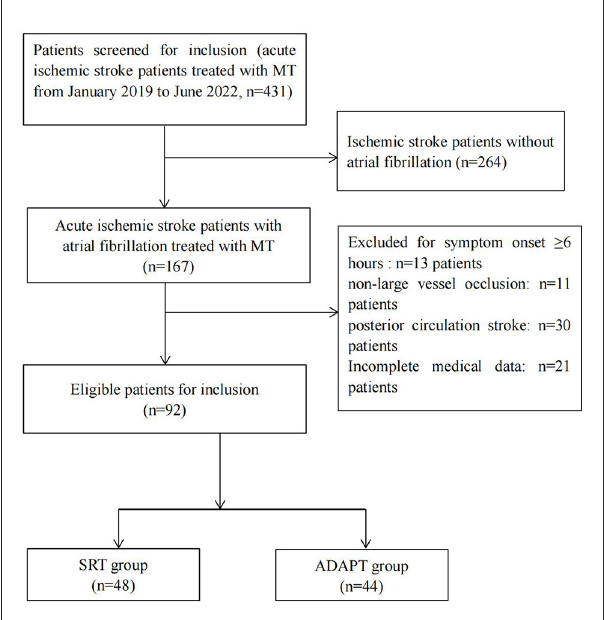
FIGURE1 Flowchart of patients inclusion process. MT, mechanical thrombectomy; SRT, stent retriever thrombectomy; ADPAT, a direct aspiration first-pass